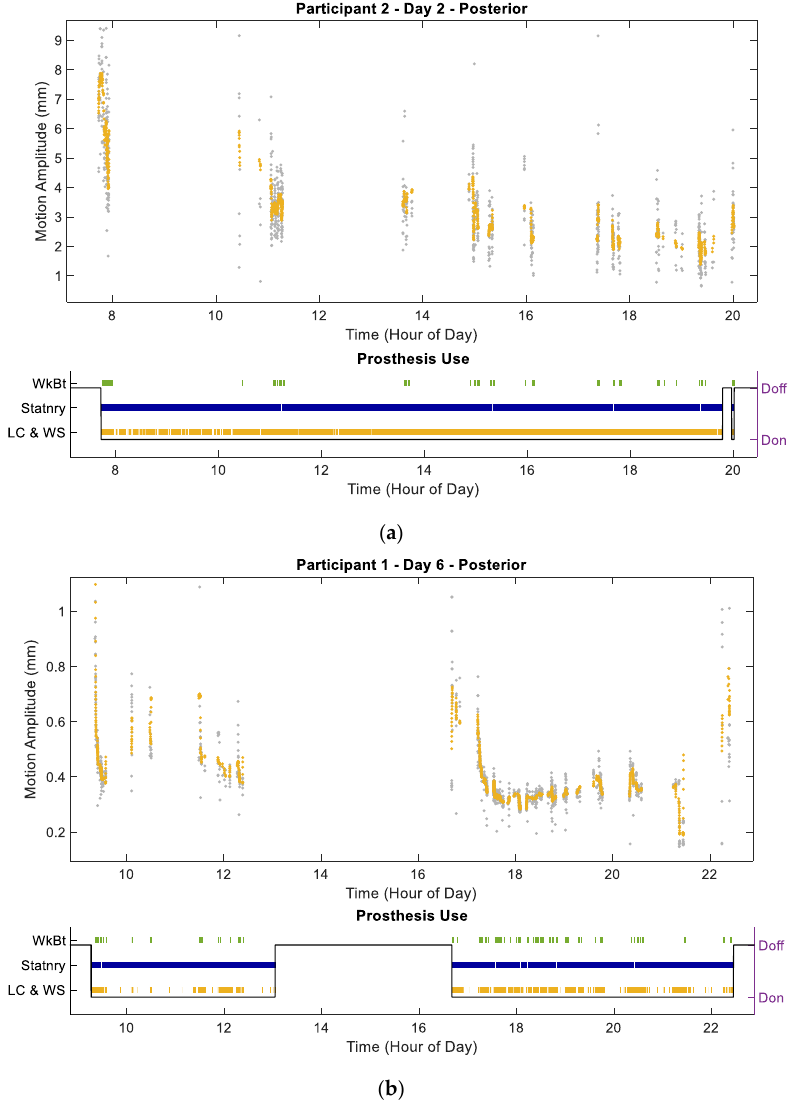
Figure 7. Motion amplitude and prosthesis use. ( a ) Participant 2, Day 2. ( b ) Participant 1, Day 6. The gray points in the motion amplitude plots ( upper panels , ( a ) and ( b ), are individual walking bout and low commotion steps. The yellow points are a 21-point moving average. The green, purple, and yellow lines in the prosthesis use plots ( lower panels , ( a ) and ( b )) indicate walking bouts (WkBt), stationary (Statnry), and low commotion and weight shift (LC & WS). The black line identifies doff and don.